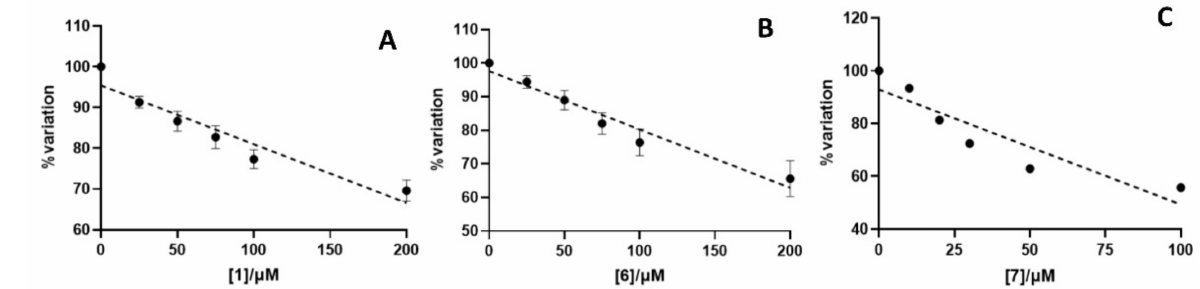
Figure 5. Antioxidant activity exerted on a fixed concentration of H 2 O 2 (200 µ M) by compound 1 ( A ), 6 ( B ) or 7 ( C ) in a range comprised between 0 and 200 µ M, dependent on the solubility of compounds. Compound 1 presented a slope of − 0.216 ± 0.034 nA/ µ M (R 2 = 0.910), 6 showed instead a slope equal to − 0.228 ± 0.018 nA/ µ M (R 2 = 0.882), while compound 7 displayed a slope of − 0.805 ± 0.075 nA/ µ M (R 2 = 0.841), demonstrating an antioxidant activity against H 2 O 2 about 3.6 times higher than the other